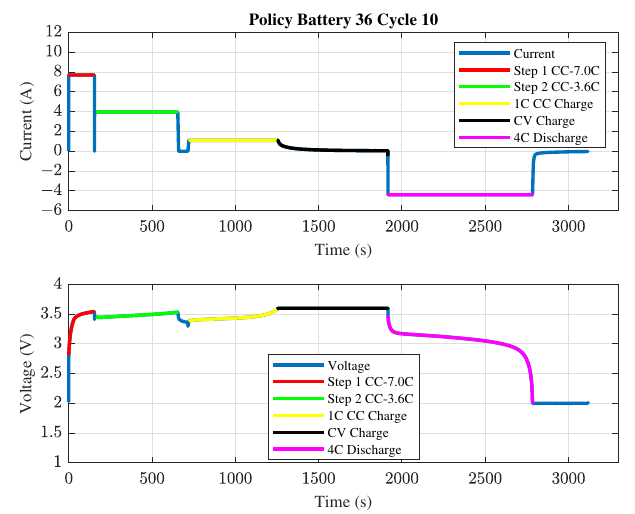
Figure 1. Example of full charge and discharge cycle for battery #36 of the dataset. Each battery has assigned a cycling policy described by a string with the